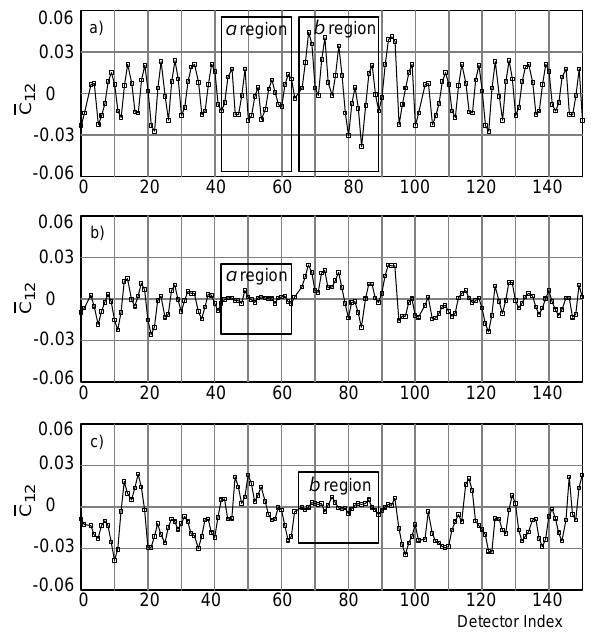
FIG. 4. Analysis of C 12 data. (a) C 12 data, (b) C 12 data with the a region fit subtracted off, (c) C 12 data with the b region fit subtracted off. The boxes shown in the figures correspond to the fit regions. that there is a good match between the data and the fit. The phase errors were s f1 (cid:1) 0.12 rad and s f2 (cid:1) 0.08 rad which, given b x (cid:9) 20 m and b y (cid:9) 20 m in the